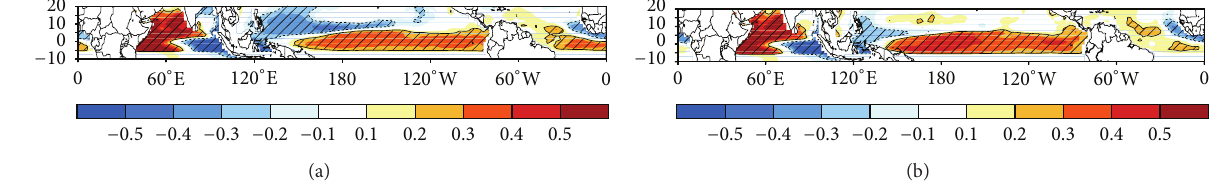
Figure 4: Correlation of IOD index with SST in OND for (a) CMIP1 and (b) CMIP2. Significance at 95%